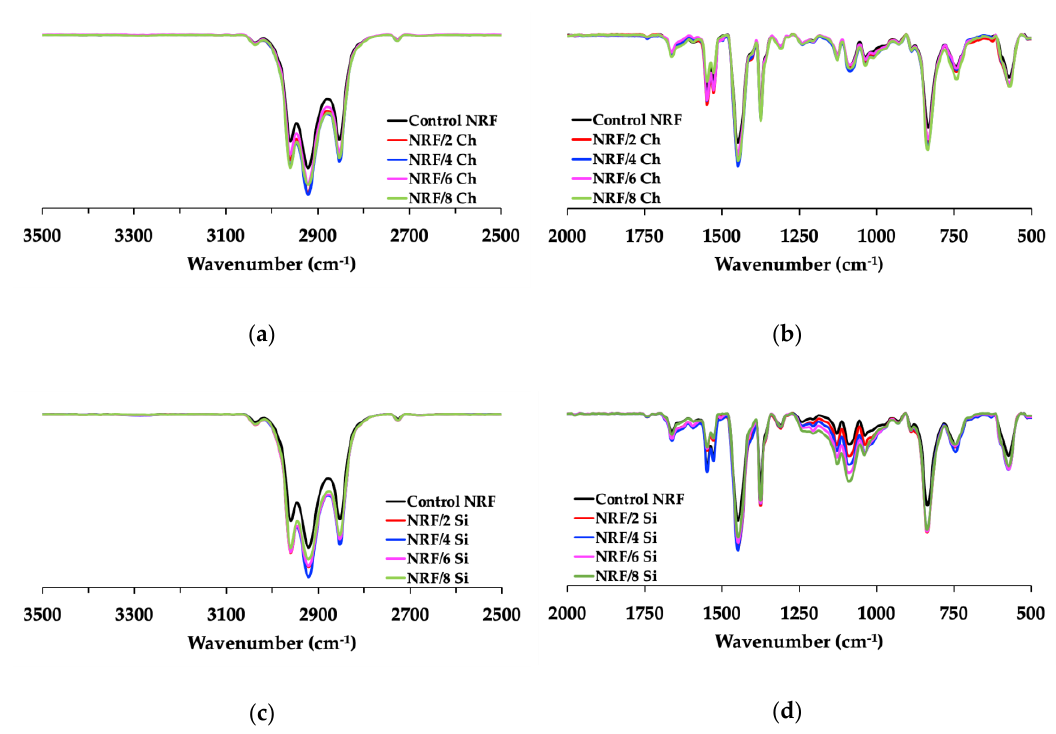
Figure 3. ATR–FTIR spectra of the NRF samples: ( a , b ) NRF with charcoal loading; ( c , d ) NRF with silica loading.